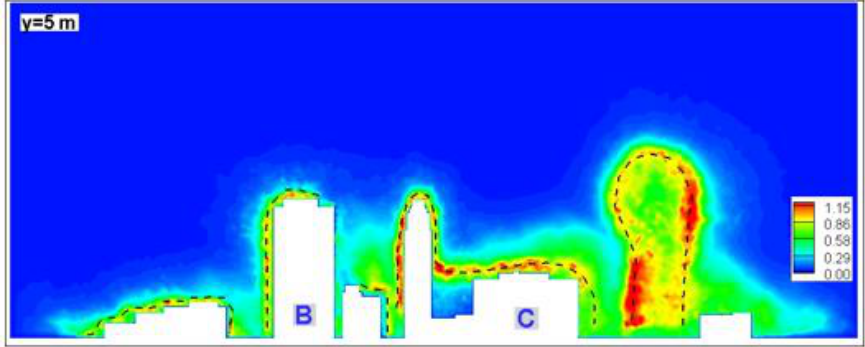
Figure 5. Turbulent intensity contours at the y = 5 m plane (see the location of the plane in Figure 2).